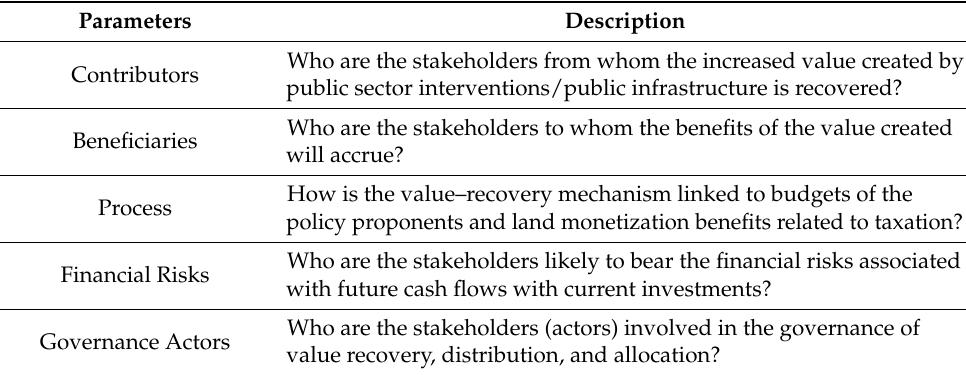
Table 1. Framework for Comparative